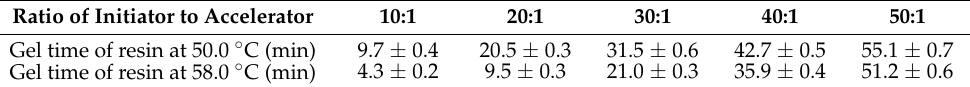
Table 1. Gel time of resin glue in different ratios of initiator to accelerator. Ratio of Initiator to